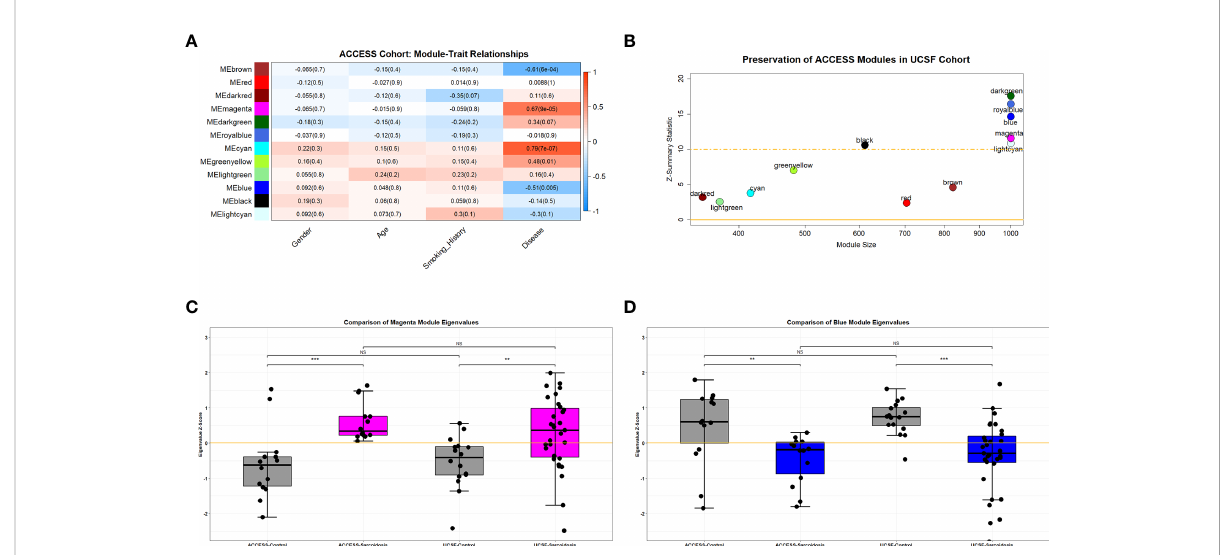
FIGURE 1 Preserved over-expressed and under-expressed modules in sarcoidosis. (A) Heatmap demonstrating WGCNA module-trait relationships in the ACCESS cohort. Columns correspond to clinical feature and rows correspond to module eigengenes. Cells depict the corresponding Spearman correlation coef fi cient and p-value (in parenthesis). Cell color indicates the strength of the correlation from strong negative (darker blue) to strong positive (darker red). Signi fi cance was determined by p-value <0.05. Cyan, greenyellow and magenta modules were found to be signi fi cantly correlated with disease (sarcoidosis), whereas blue and brown modules were found to be signi fi cantly but negatively correlated with disease. There were no signi fi cant relationships between module expression and gender, age, or smoking history. (B) Scatterplot demonstrating module size and module preservation between cohorts based on Z-summary statistic. The magenta and blue modules were strongly preserved (Z-summary statistic > 10) between the ACCESS and UCSF cohorts. (C, D) Module eigengenes, a measure of module expression, demonstrated that the magenta module was similarly over-expressed in sarcoidosis cases (C) and the blue module was similarly under-expressed in sarcoidosis (D) between cohorts. NS, non-signi fi cant; **p-value < 0.01; ***p-value < 0.001; Mann-Whitney U